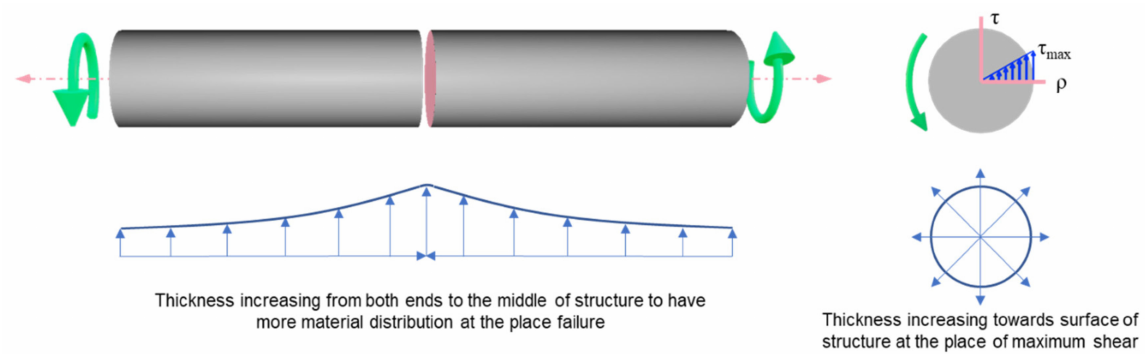
Figure 2. Stress concentration in torsional loading and failure of ductile and brittle materials.